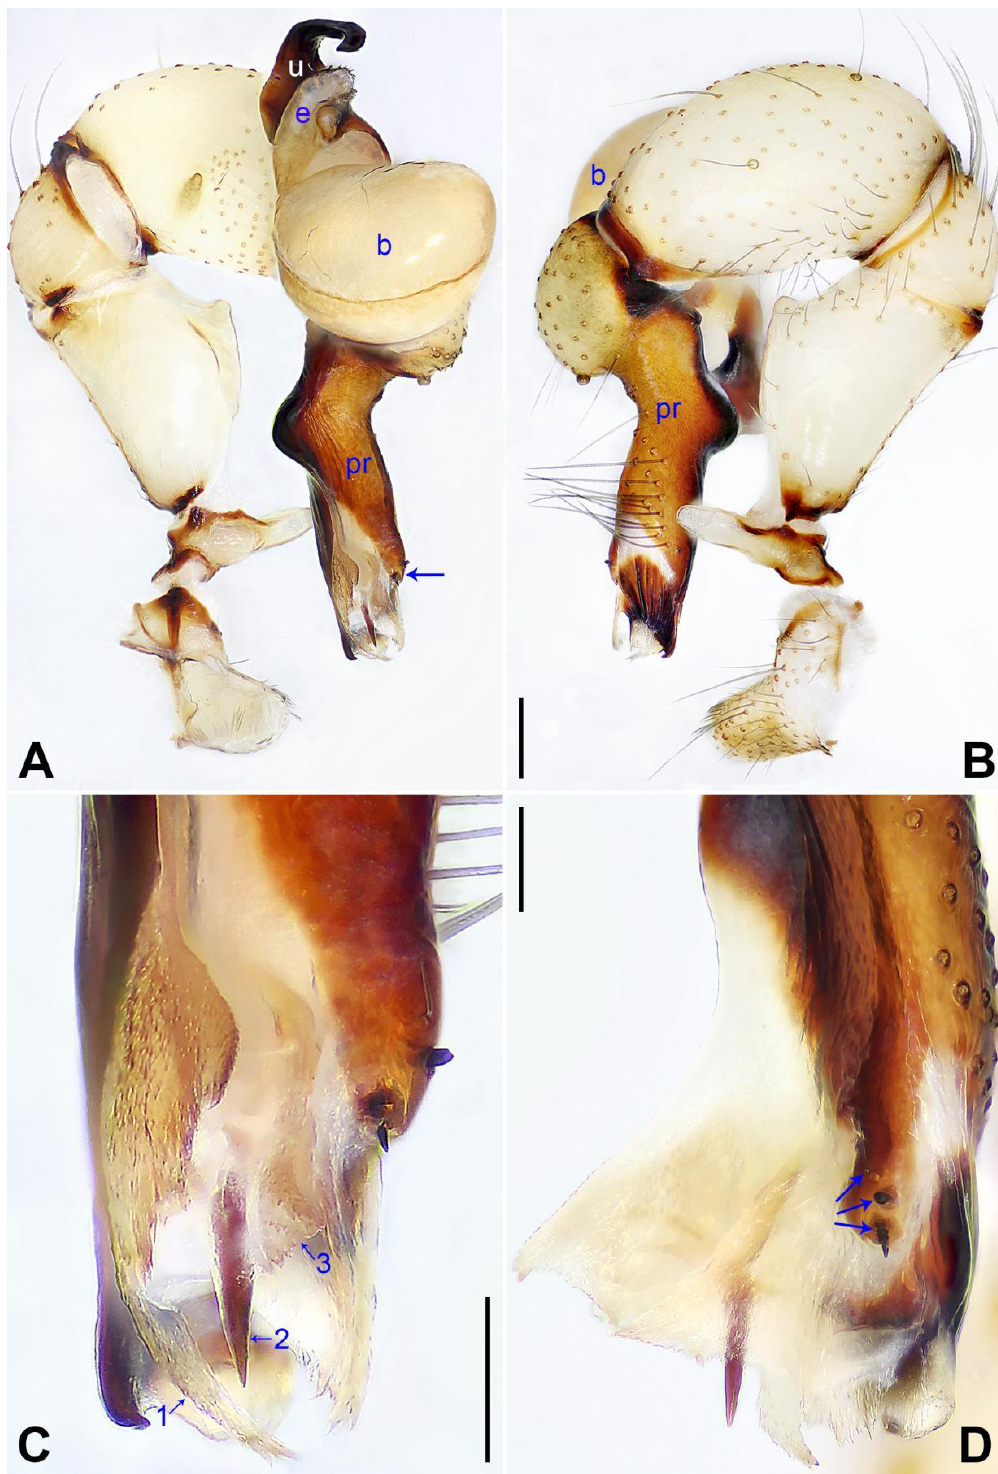
Figure 7. Pholcus lishi sp. nov., holotype male: ( A ) pedipalp, prolateral view (arrow points at strongly protruding subdisto–dorsal part); ( B ) pedipalp, retrolateral view; ( C ) distal part of procursus, prolateral view (arrow 1 points at narrow prolateral membranous process, arrow 2 points at spine- shaped distal apophysis, arrow 3 points at indistinct dorsal membranous lamella); ( D ) distal part of procursus, dorsal view (arrows point at dorsal spines). b = bulb, e = embolus, pr = procursus, u = uncus. Scale bars: ( A , B ) = 0.20 mm; ( C , D ) = 0.10 mm.